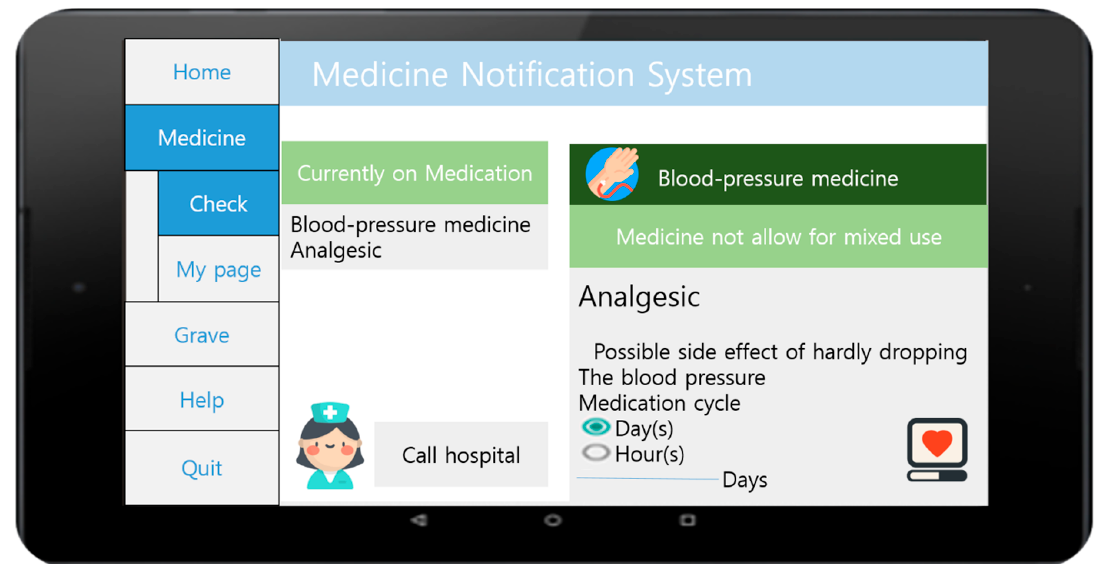
Figure 11. Intake Notification System Implemented via App.